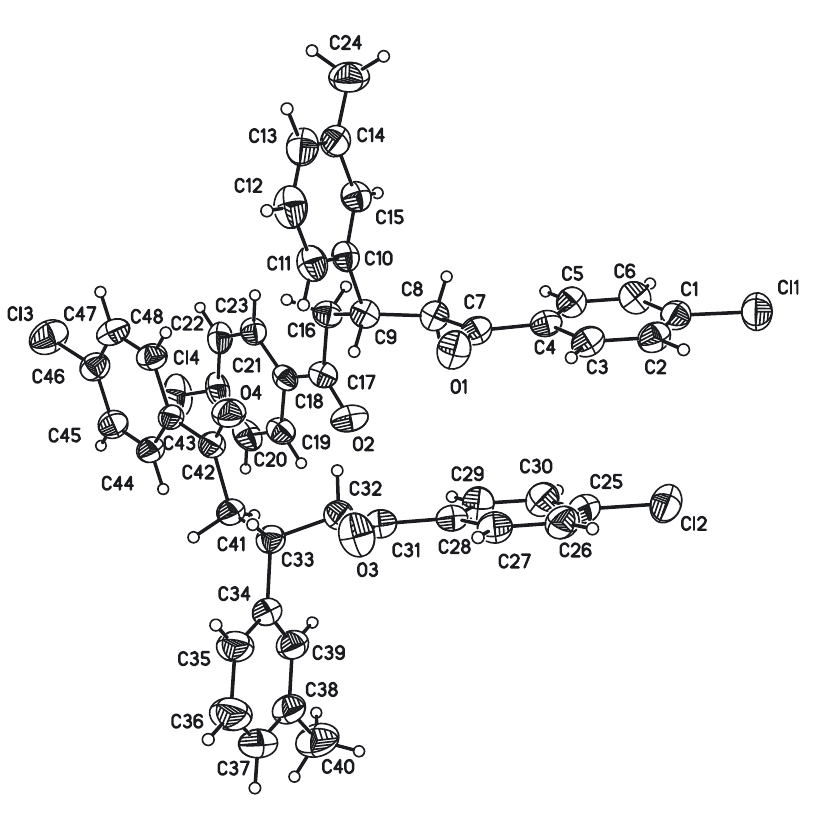
Table  : Data collection and